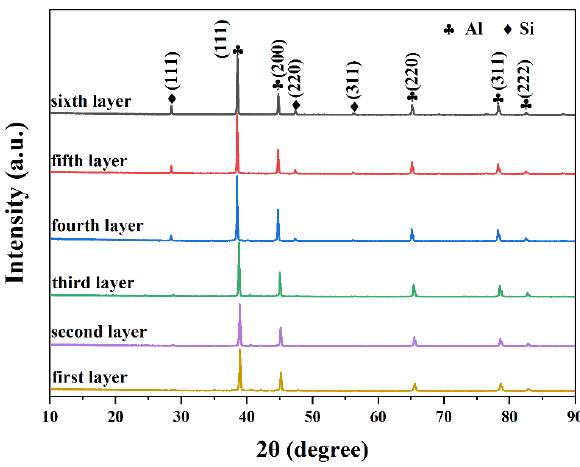
Materials 2021 , 14 , x FOR PEER REVIEW Figure 4. XRD results for each layer of gradient composite alloy. Figure 4. XRD results for each layer of gradient composite alloy.